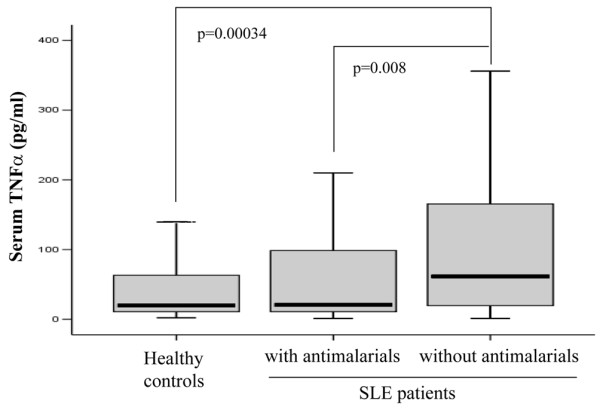
Antimalarial treatment downregulates tumor necrosis factor (TNF)α serum levels in systemic lupus erythematosus (SLE) patients. TNFα serum levels were quantified by ELISA techniques in 171 SLE patients and 215 healthy controls. All patients were classified as users or nonusers of antimalarial drugs during the last three months before sampling. Differences were evaluated by the Mann-Whitney U test.